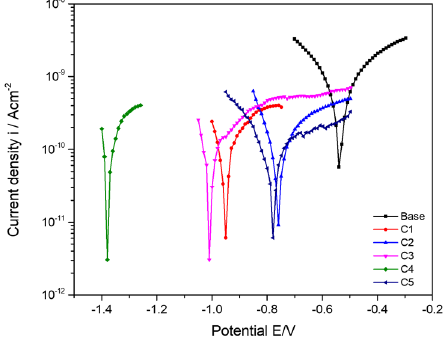
Figure 9. Tafel plots for all the sample after potentiodynamic polarization measurement on the 30th day.